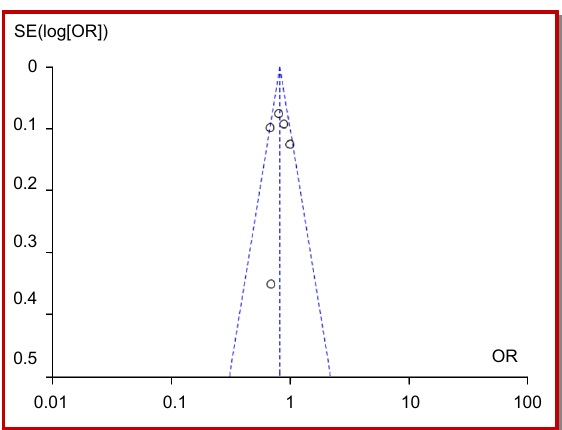
Figure 5: Funnel plot of risk of bleeding event between NO- ACs and vitamin K antagonists